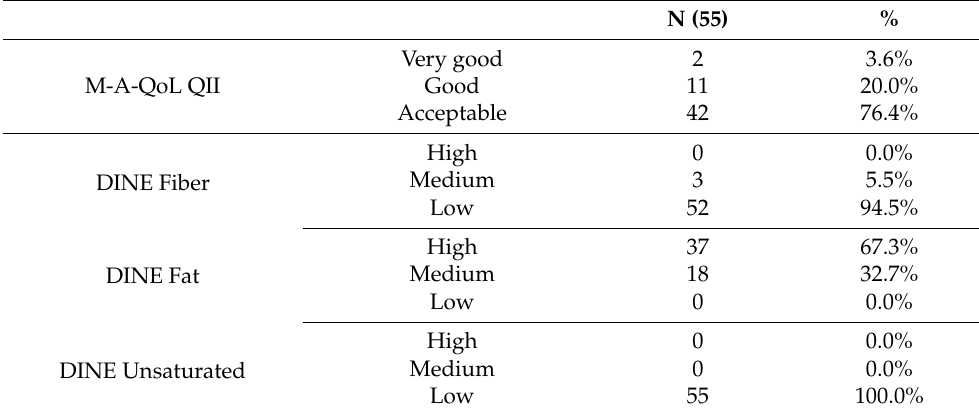
Table 2. Dietary Instrument for Nutrition Education (DINE) Questionnaire and Moorehead–Ardelt Quality of Life Questionnaire II classification (M-A-QoL